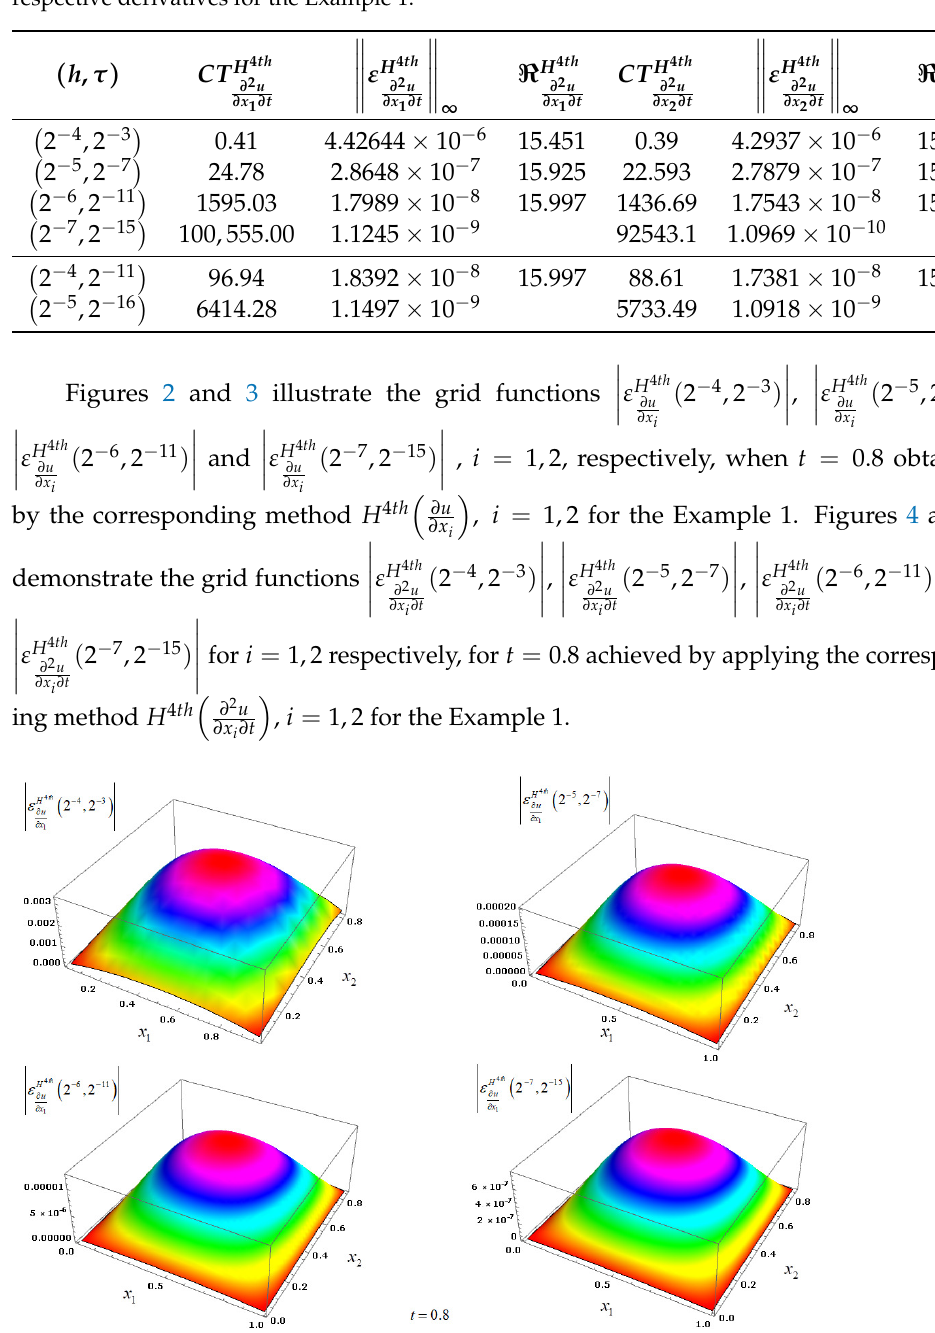
Figure 2. The grid function of absolute errors when t = 0.8 obtained by the method H 4 th the Example